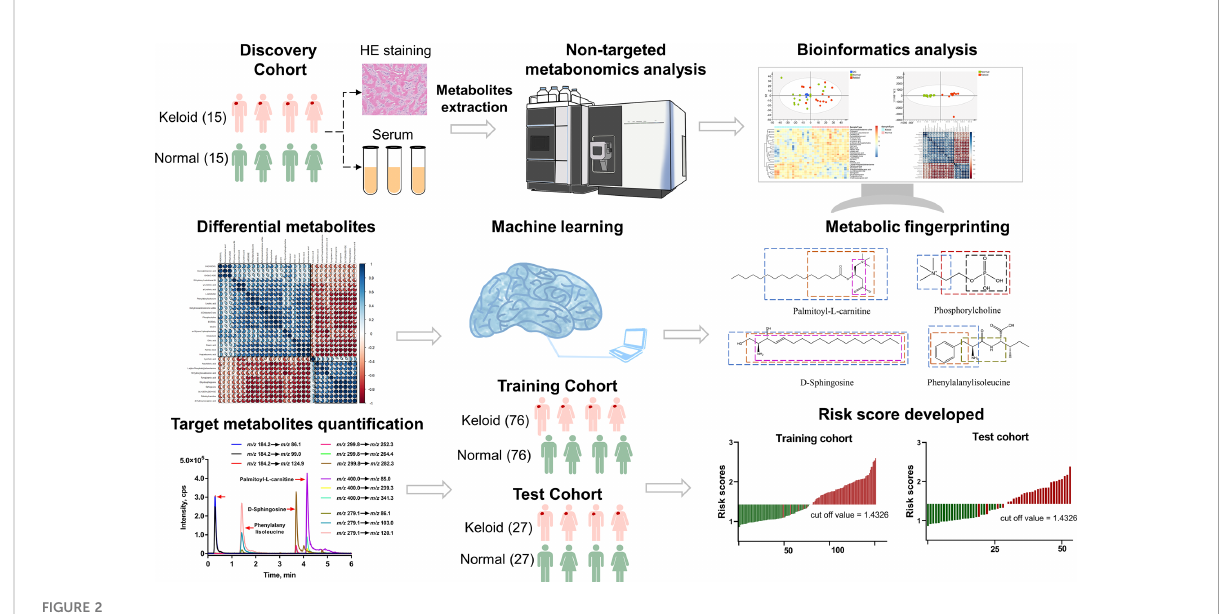
FIGURE 2 Work fl ow of the study